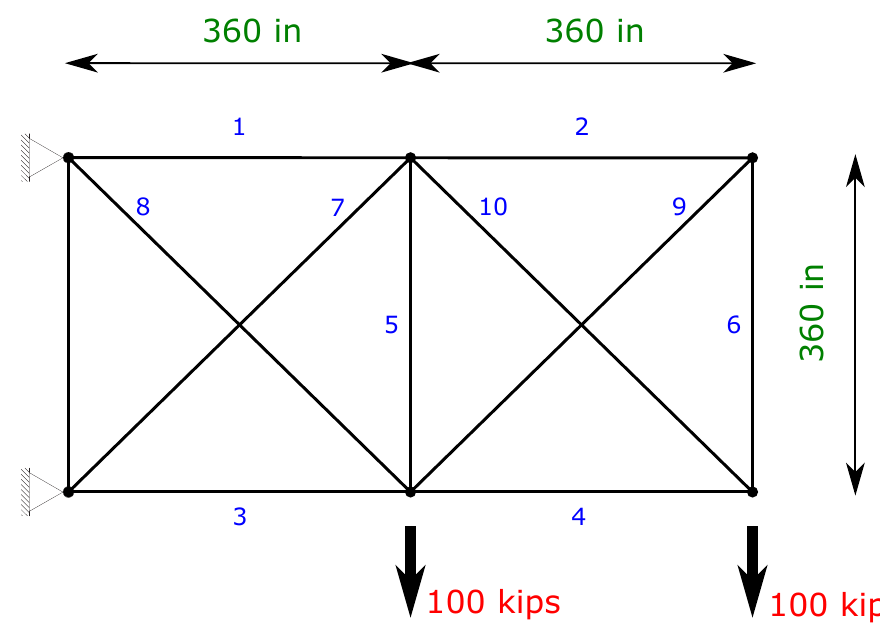
Figure 6. Graphical representation of the 10 bar truss design optimization